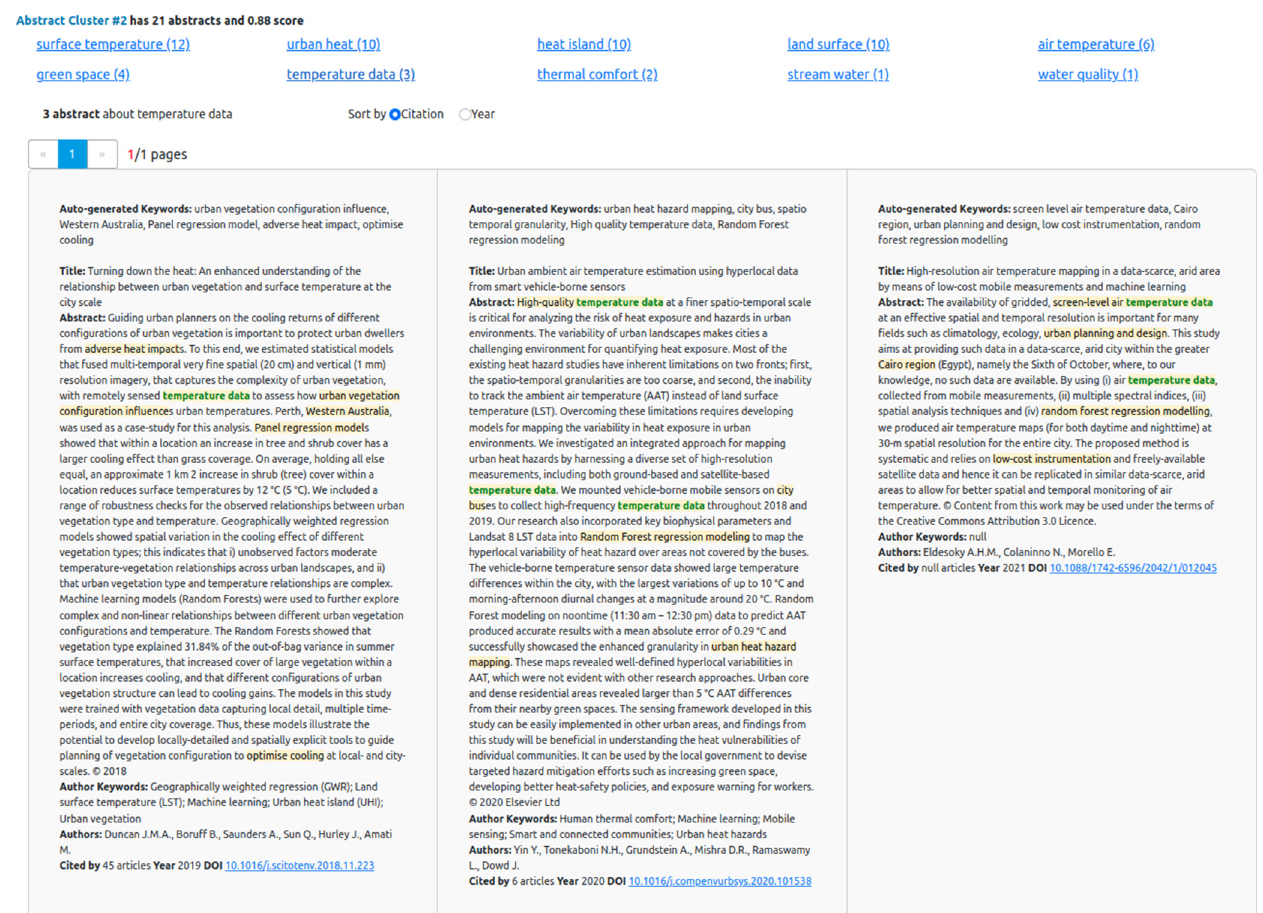
Figure 6. Abstract cluster visualization for a single cluster, #2. The top panel displays 10 frequent terms of the selected cluster. Clicking a term, temperature data , displays the abstracts and the auto- generated keywords from the keyword extraction phase.